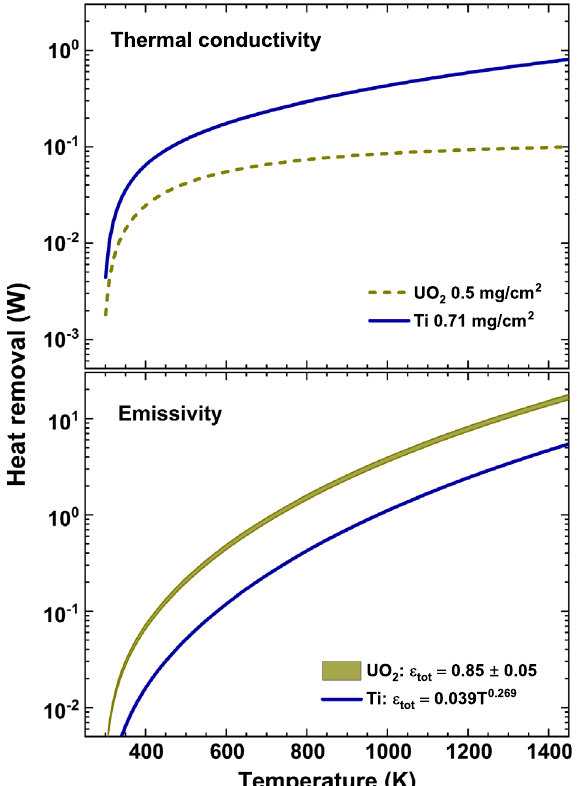
FIG. 3. Heating powers removed due to the UO 2 target and Ti backing thermal conductivity are shown as functions of temper- ature in the upper panel (lines). In the bottom panel, similar heating powers removed by radiation emitted from the target and backing surfaces are shown by filled area and line, respectively. See details in the